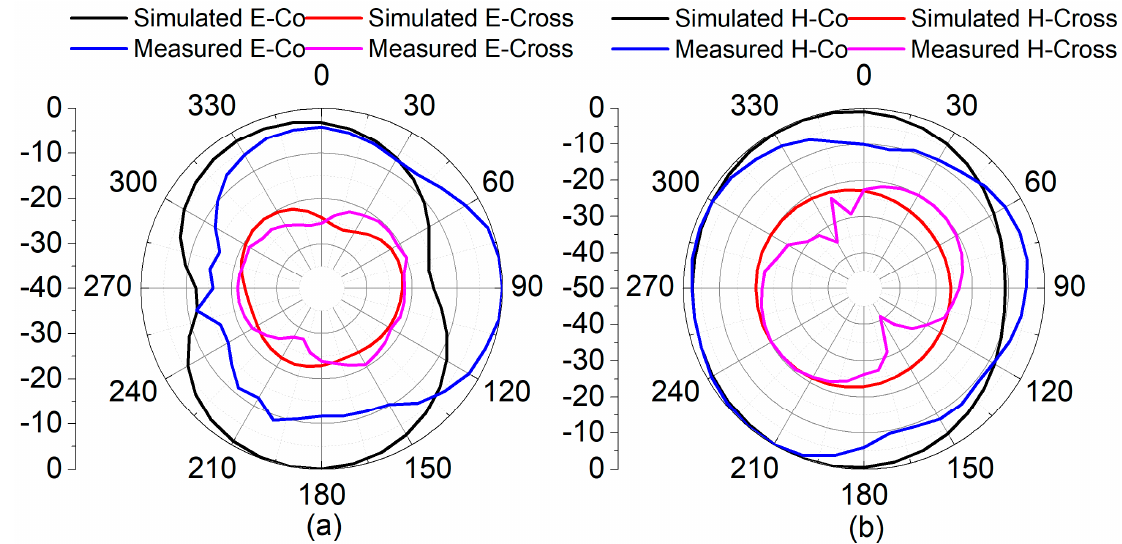
Figure 29. Simulated and measured normalized radiation patterns at 1.77 GHz: ( a ) E-Plane and ( b ) H-Plane.